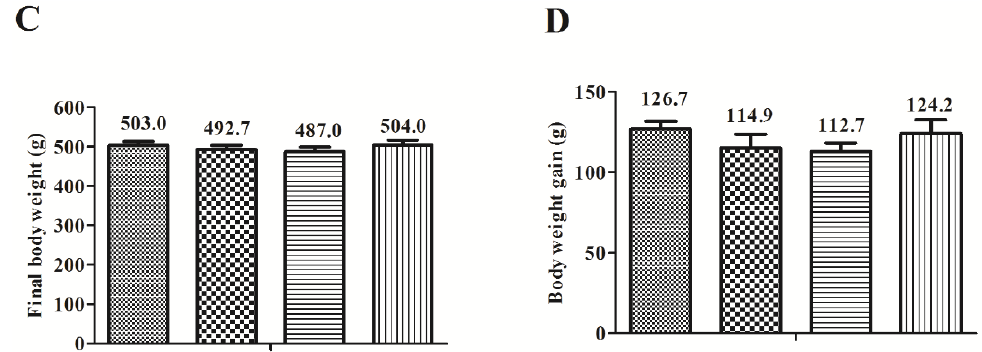
Figure 1. Food intake and body weight. ( A ) Average daily food intake; ( B ) cumulative food intake; ( C ) final body weight; and ( D ) body weight gain in rats given diets containing different dietary fibers for three weeks. Diets were control (C) or supplemented with 2% fiber of konjac flour (KF), pregelatinized waxy maize starch plus guar gum (PG) or pregelatinized waxy maize starch plus xanthan gum (PX); Values are mean ± SEM of n = 8 per group. Bars with different letters indicate a significant difference ( p < 0.05).